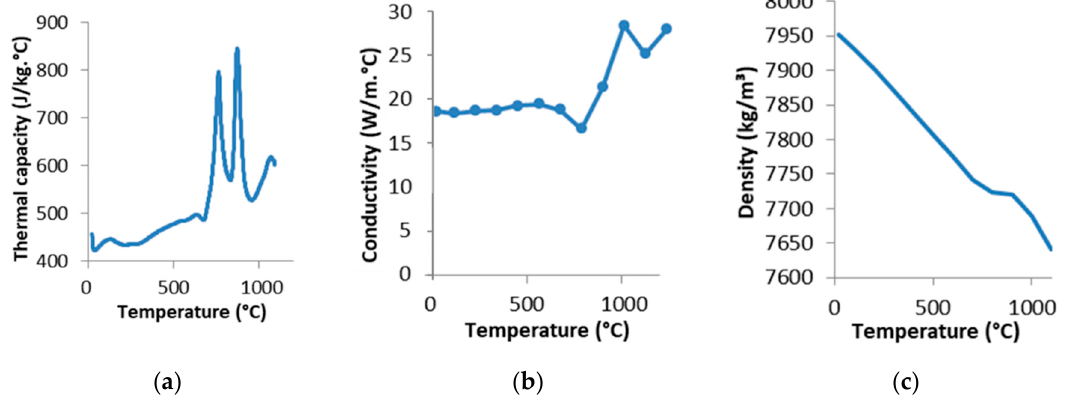
Figure 6. Thermophysical properties of HSS M4: ( a ) thermal capacity ( c p ), ( b ) thermal conductivity ( k ), and ( c ) density ( ρ ) .